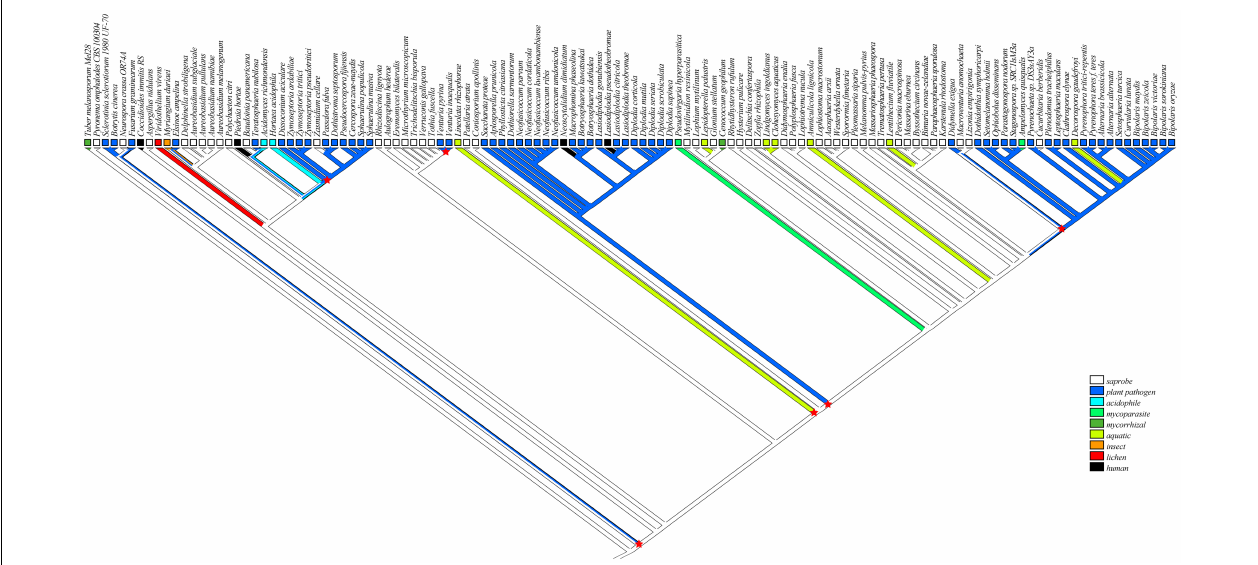
FIGURE 2 | Reconstruction of ancestral lifestyle character state of Dothideomycetes using Mesquite based on parsimony model as saprobe. Major lifestyle shifts were marked by six red star symbols.